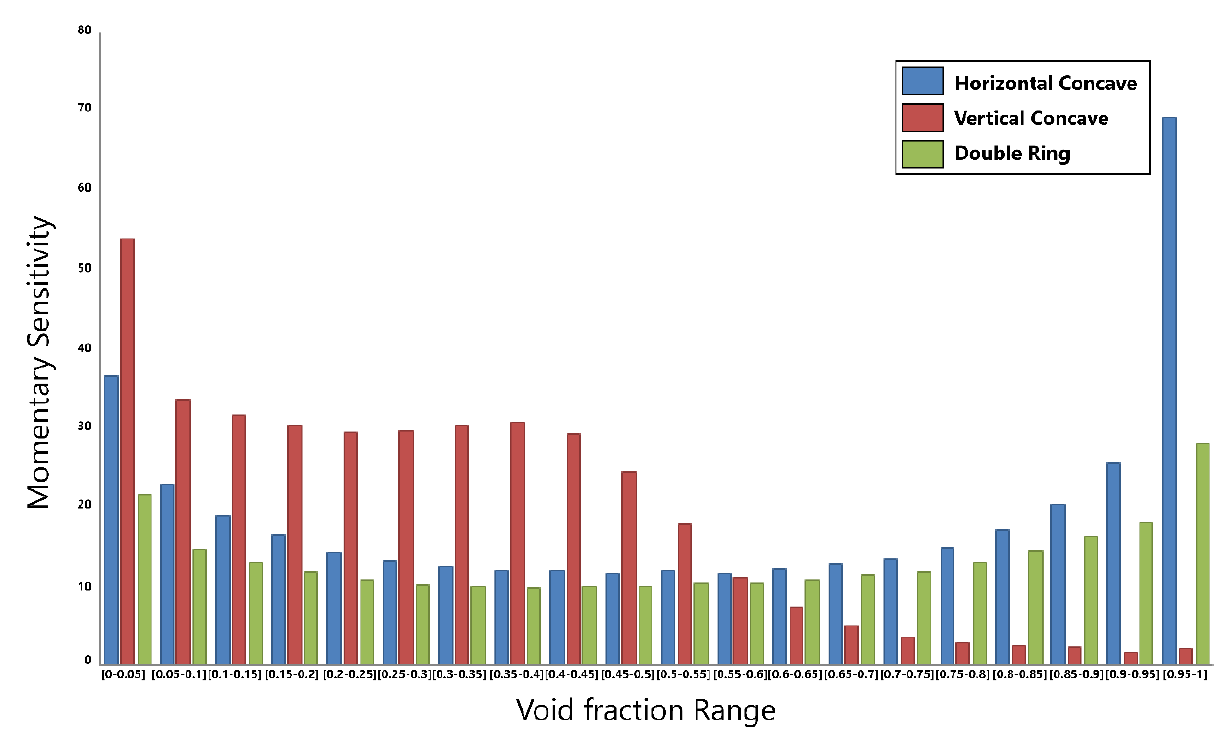
Figure 11. Comparing horizontal concave, vertical concave, and double-ring sensors in different ranges.